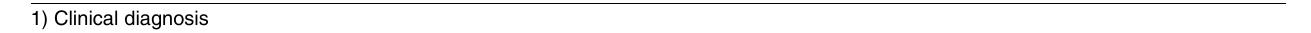
TABLE 3 Approach to a suspected adverse drug reaction 1) Clinical diagnosis Obtain a detailed history of the name of the drug(s), indications for the drug, concurrent infections and other clinical features, time lapse between when the drug was taken and the onset of the reaction, and history of resolution of symptoms with drug withdrawal Perform physical examination for skin rashes (urticaria, angioedema, maculopapular rashes, dermatitis and vasculitis) and their distribution. Drug reactions may involve any